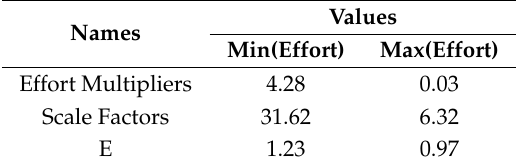
Table 7. COCOMO Regression Parameters SF, EM, and E